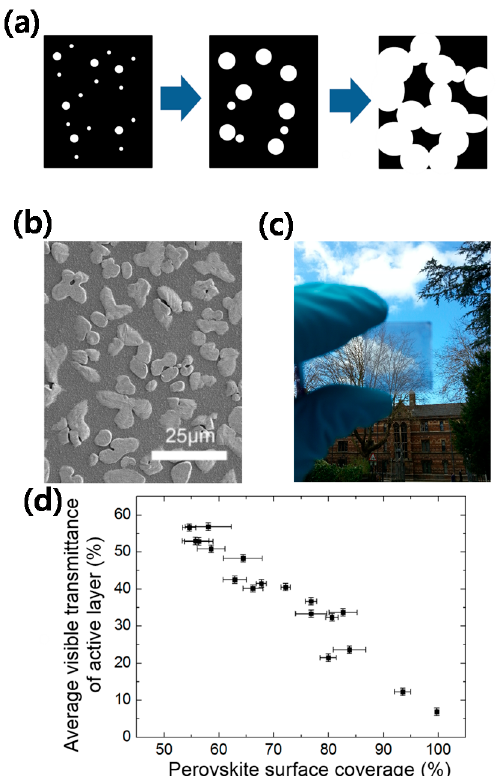
Figure 8. Controlled dewetting for varying transmittance of a perovskite film. ( a ) Schematic of the film dewetting process showing morphology change over time, from as-cast film to discrete islands. Perovskite material and pores are represented with black and white, respectively; ( b ) Scanning electron micrograph of the top surface of a representative film of perovskite islands (paler regions) on a TiO 2 -coated FTO substrate; ( c ) Photograph of a STPSC; ( d ) Dependence of average visible transmittance of the active layer on perovskite surface coverage. Reprinted with permission from [64]. Copyright 2014 ACS.